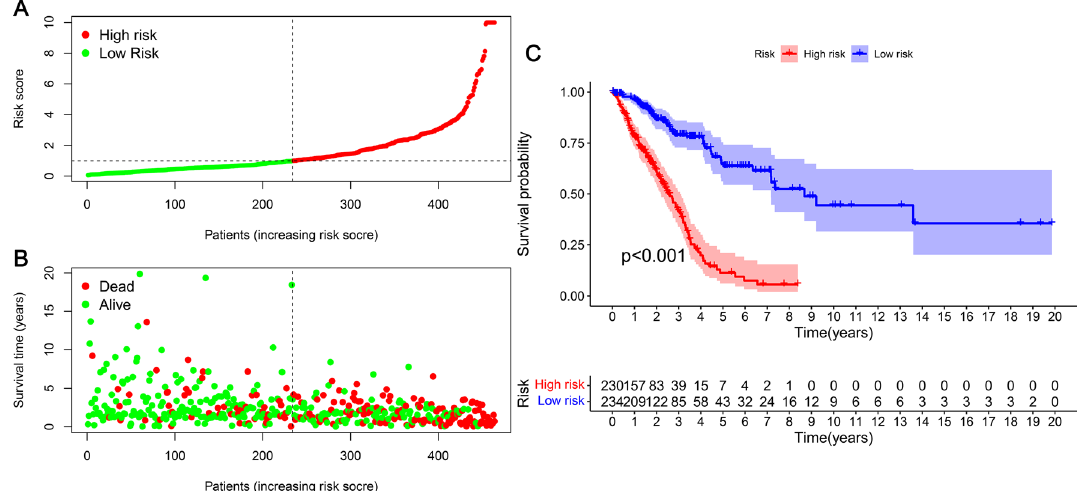
Figure 4. LUAD prognosis prediction risk model created by 20 aging-related lncRNAs. ( A ) Patients were categorized into low- and high-risk groups with the aid of risk scores. ( B ) Scatter plot of the relationship between patient risk scores and survival outcomes. ( C ) Kaplan–Meier curves were constructed to derive survival differences between high- and low-risk groups. Individuals in the low-risk group were found to have a longer survival